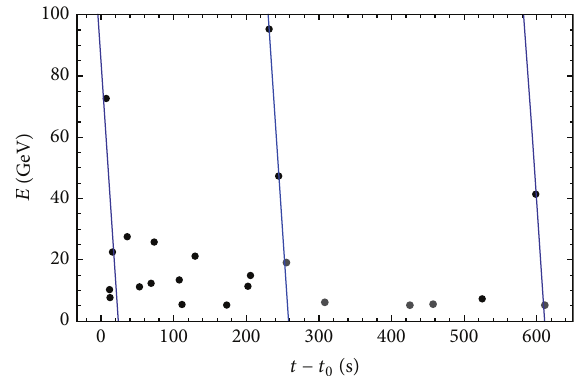
Figure 3: The three parallel straight lines here shown identify cases where photons on one such worldline could have been even emitted simultaneously (up to experimental errors) if (1) holds at the relevant energies.